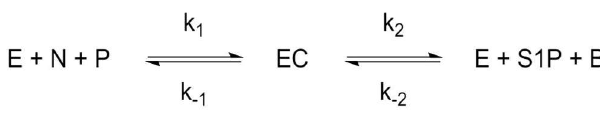
Scheme 1. Reaction equation of an enzymatic nucleoside phosphorylation. Enzyme (E), nucleoside (N), phosphate (P), enzyme complex (EC), pentose-1-phosphate (S1P), free nucleobase (B), reaction